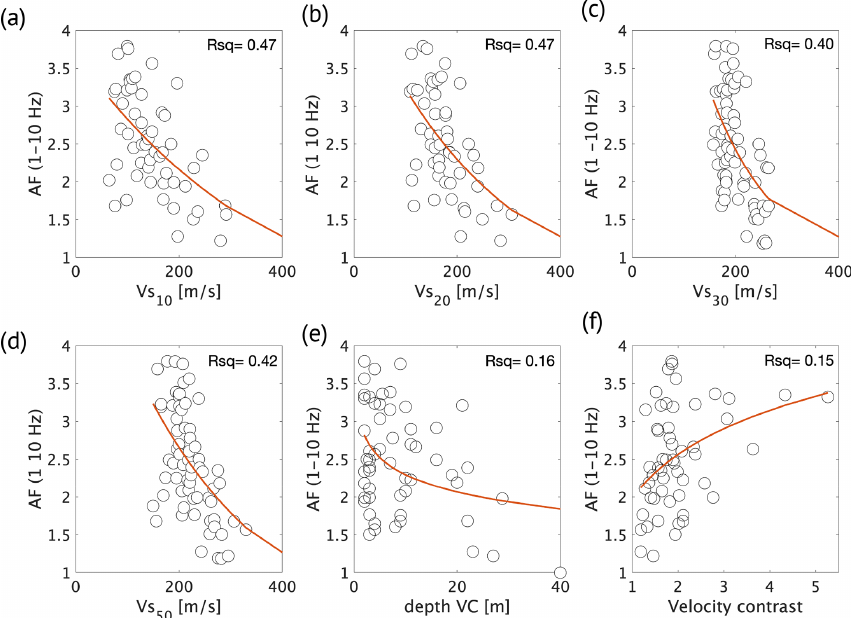
Figure 7. Each panel depicts the fitted function and the coefficient of determination ( R sq ) of the AF (1–10Hz) per G-network borehole location and the corresponding subsurface parameter. (a) V s10 , (b) V s20 , (c) V s30 , (d) V s50 , (e) depth of the velocity contrast, and (f) size of the velocity